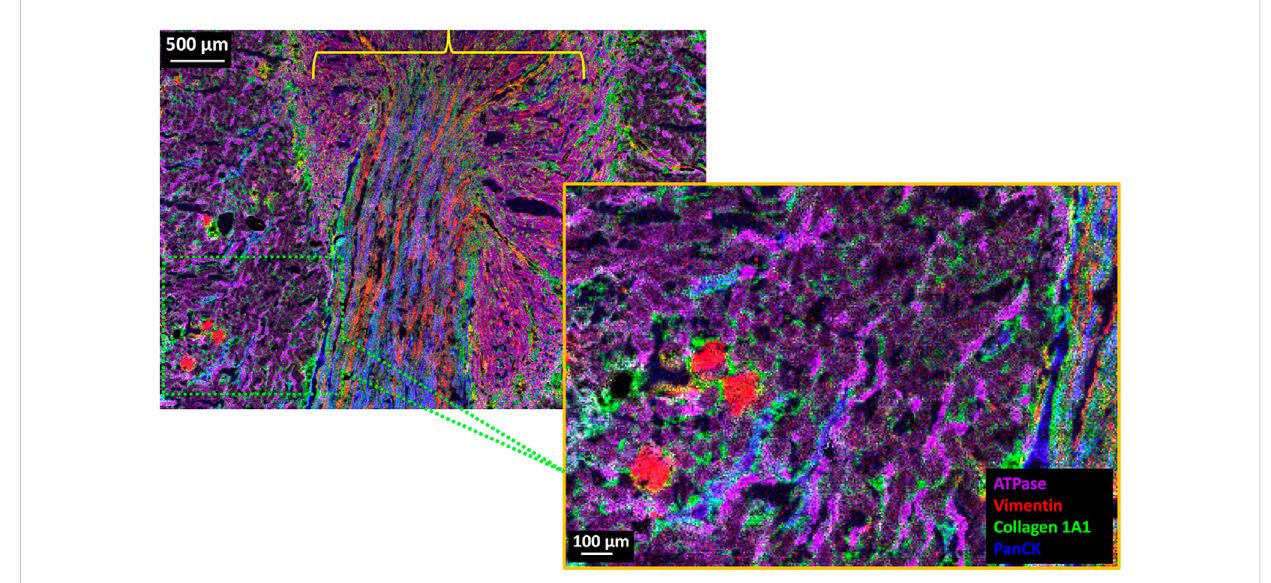
FIGURE 4 4-Plex MALDI-IHC image of FF normal rat kidney tissue section. (Upper Left) 18 mm 2 (5.08 × 3.52 mm) area of the kidney tissue which consists of 715,264 individual pixels which took a total of approximately 11 h of data acquisition (~18 pixels/s) on a timsTOF fl eX equipped with microGRID and recorded at 5 µm pixel size. (Lower Right) 5x magni fi cation of the area shown in the hatched green box which is a portion of the renal cortex. The yellow bracketindicatesthegeneralvicinityofthekidneymedulla.BasecolorsforbothimagesareNa + /K + ATPase(purple),vimentin(red),collagen(green), and panCK